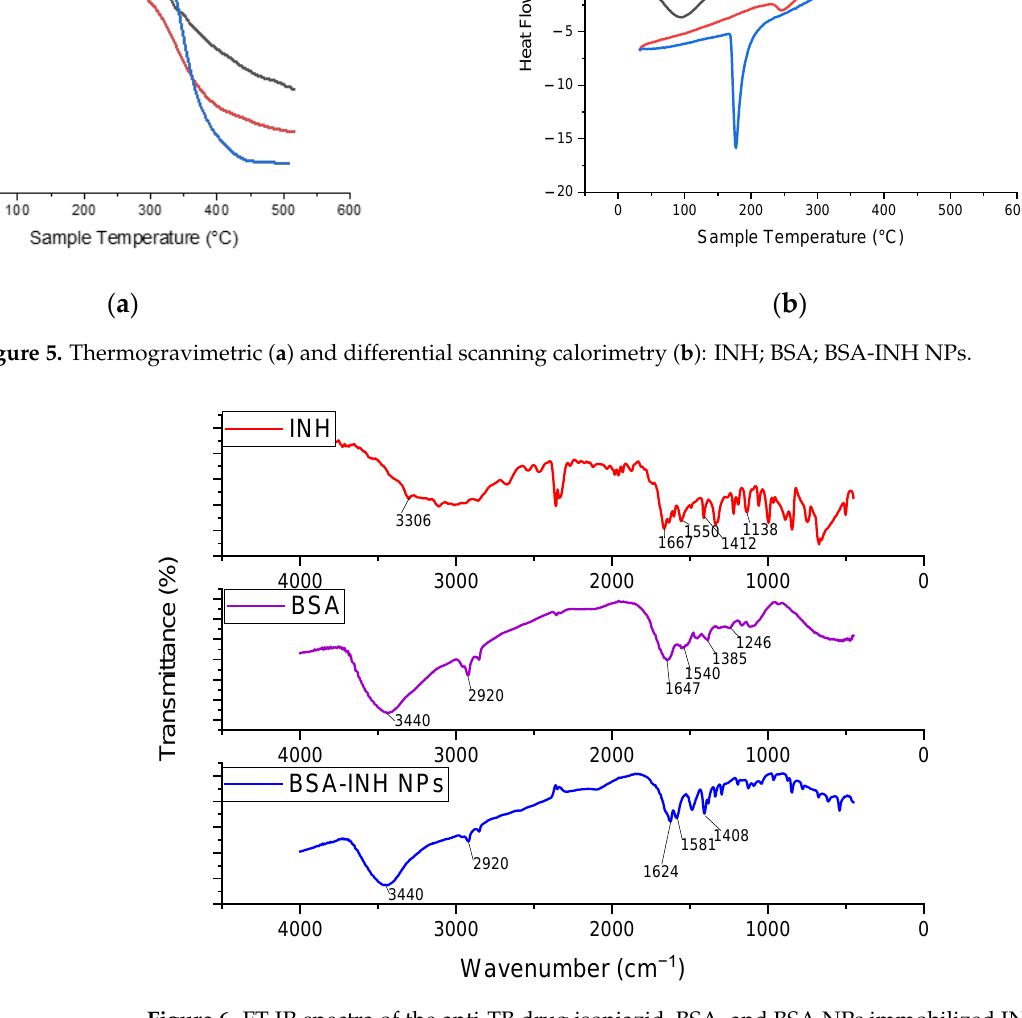
Figure 6. FT-IR spectra of the anti-TB drug isoniazid, BSA, and BSA NPs immobilized INH.